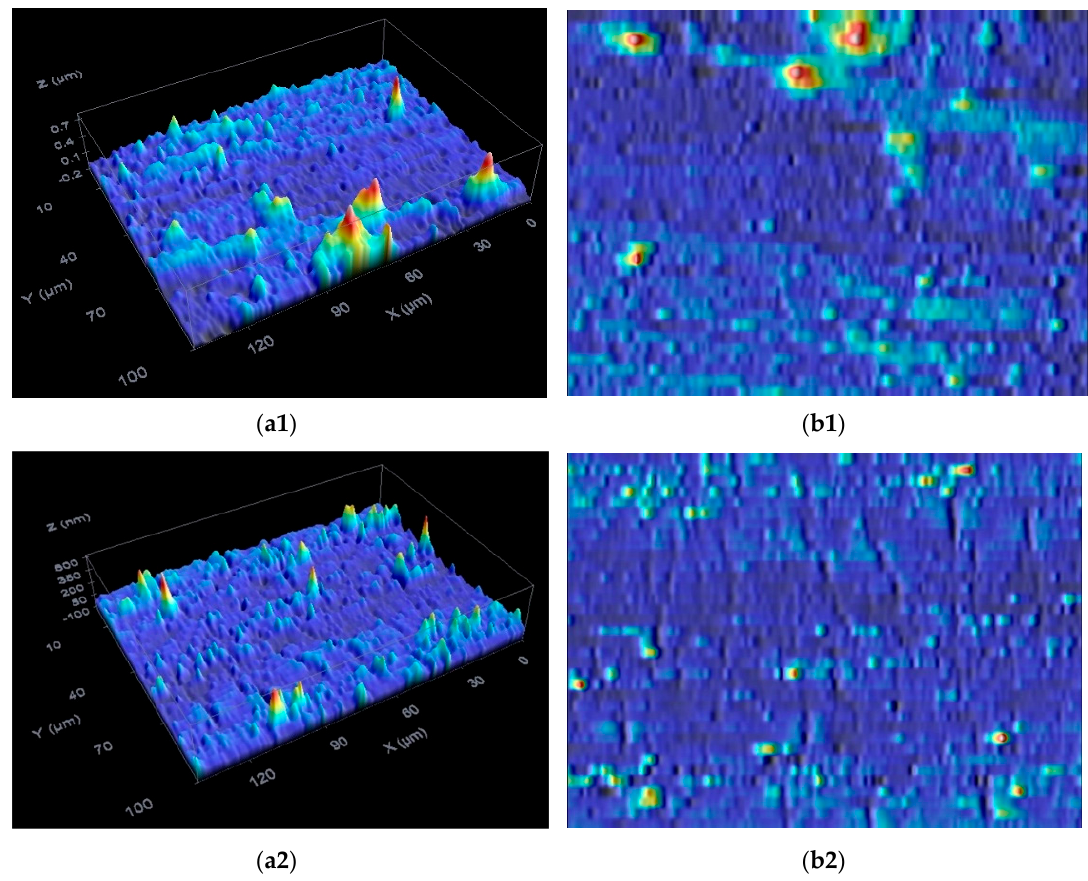
Figure 20. Typical surface morphology within the necked area in samples programmed at 135 °C.